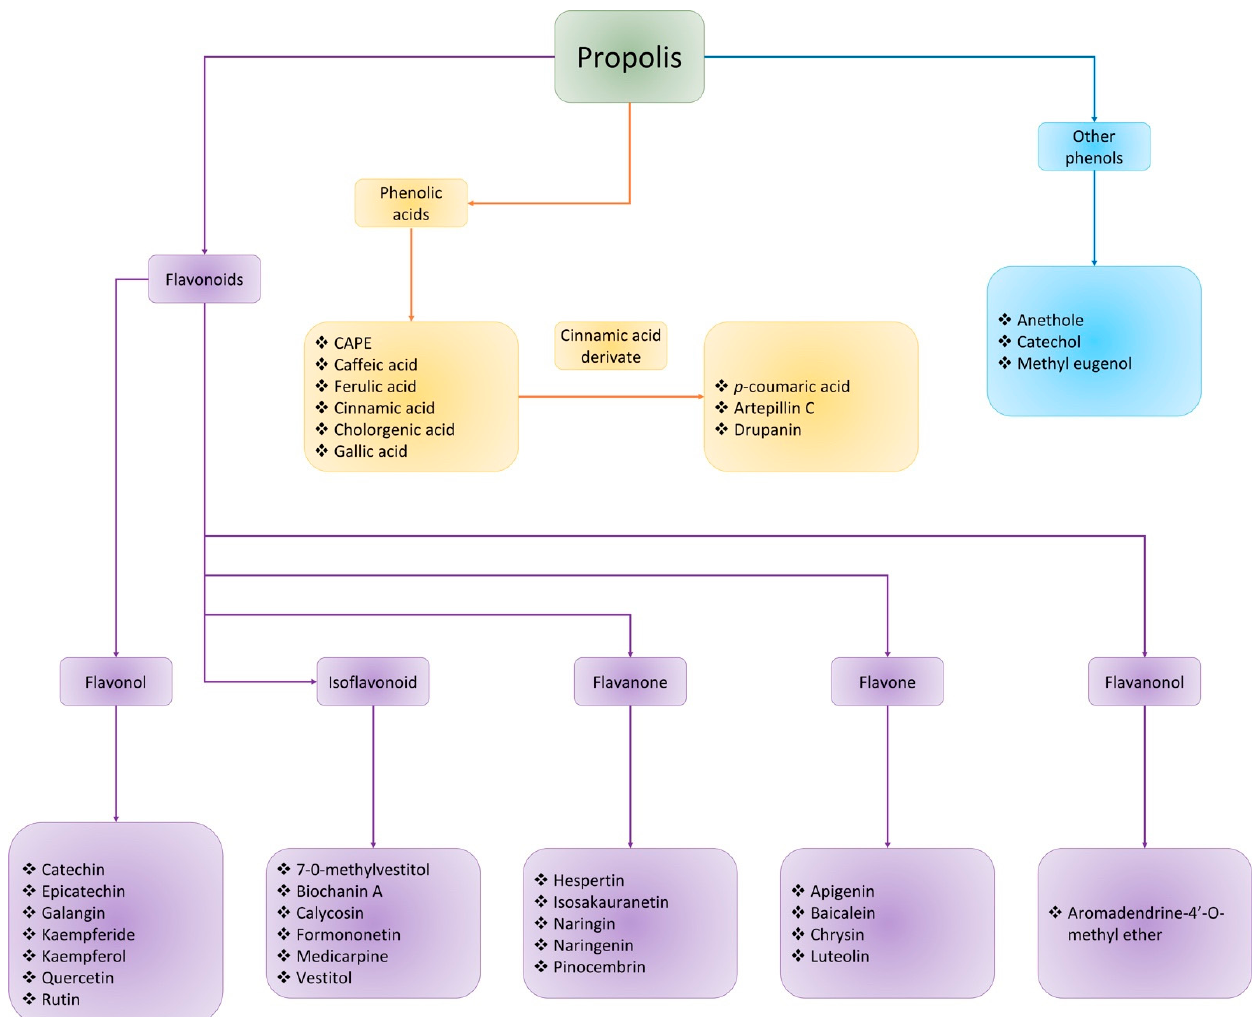
Figure 4. Class of phenolic compounds contained in propolis related to their gastroprotective activity. Purple boxes shown flavonoid types reported in the chemical composition of different propolis with gastroprotective activity. Yellow boxes are shown phenolic acids as well as cinnamic acid derivate compounds recorded in propolis samples. Blue boxes are shown other phenolic compounds reported with gastroprotective activity identified in propolis samples of Brazil and Mexico.